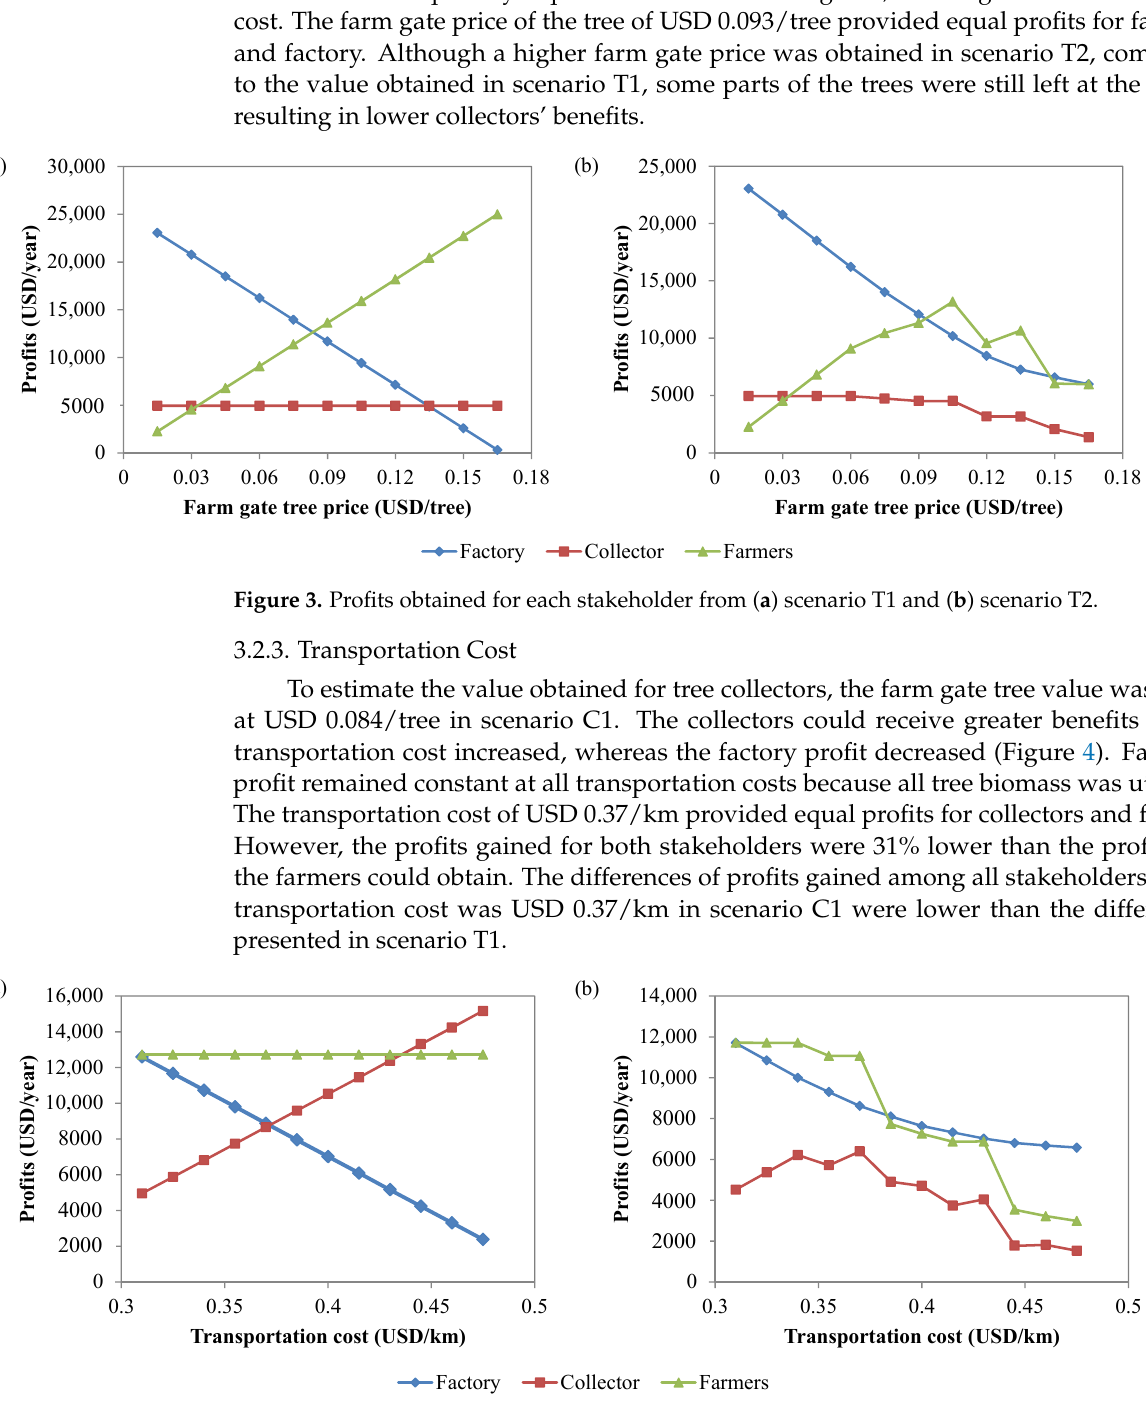
Figure 4. Pro fi ts obtained for each stakeholder from ( a ) scenario C1 and ( b ) scenario C2. Figure 4. Profits obtained for each stakeholder from ( a ) scenario C1 and ( b ) scenario